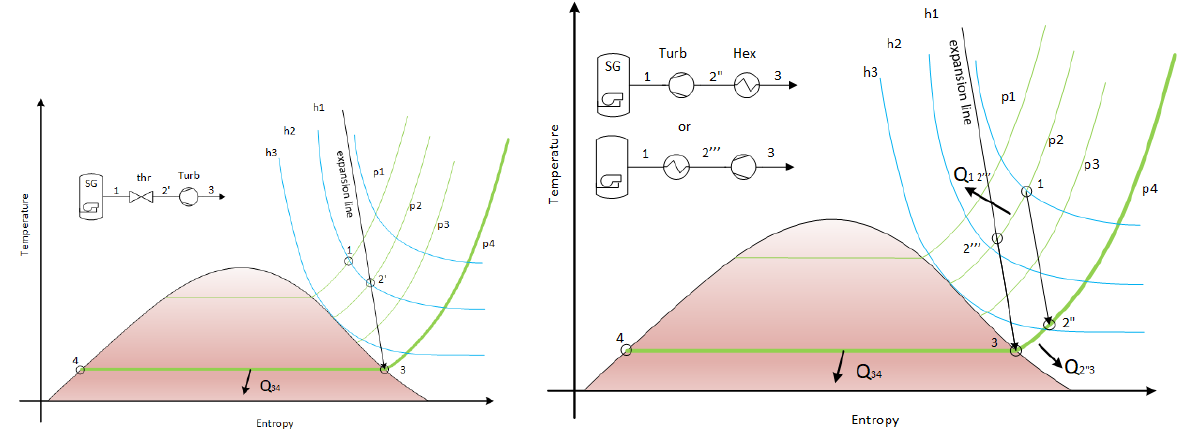
Figure 3. Improved steam conditioning processes; ( left ): second scenario (II), using throttle and turbine; ( right ): third scenario (III), using turbine and heat